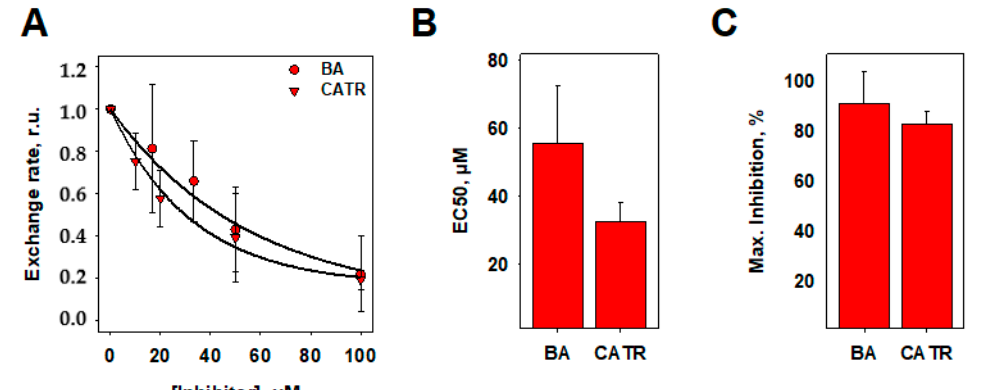
Figure 5. Dose-dependence of ANT1-mediated ADP / ATP exchange in the presence of specific inhibitors (CATR and BA). ( A ) Dose-response curves of ANT1-mediated ADP / ATP exchange rates measured with a fluorescence assay in the presence of bongkrekic acid (BA, circles) and carboxyatractyloside (CATR, triangles) normalized to the full, uninhibited rate. Lines are fits of an exponential function to the data. ( B ) EC 50 and ( C ) maximum inhibition by BA and CATR obtained as fit parameters from ( A ). In all measurements, the bu ff er contained 50 mM Na 2 SO 4 , 10 mM Tris, 10 mM MES and 0.6 mM EGTA at pH = 7.34 and T = 297 K. Lipid membranes were made of 45:45:10 mol% of DOPC, DOPE and CL, respectively. The lipid concentration was 1.0 mg / mL and the liposome diameter was approximately 100 nm. The concentration of ANT1 was 6.70 µ g / mL, and the concentrations of ATP, ADP, Mg 2 + , and Magnesium Green (MgGr) TM were 2 mM, 2 mM, 1 mM and 3 µ M, respectively. Data are shown as the mean ± SD of at least three independent